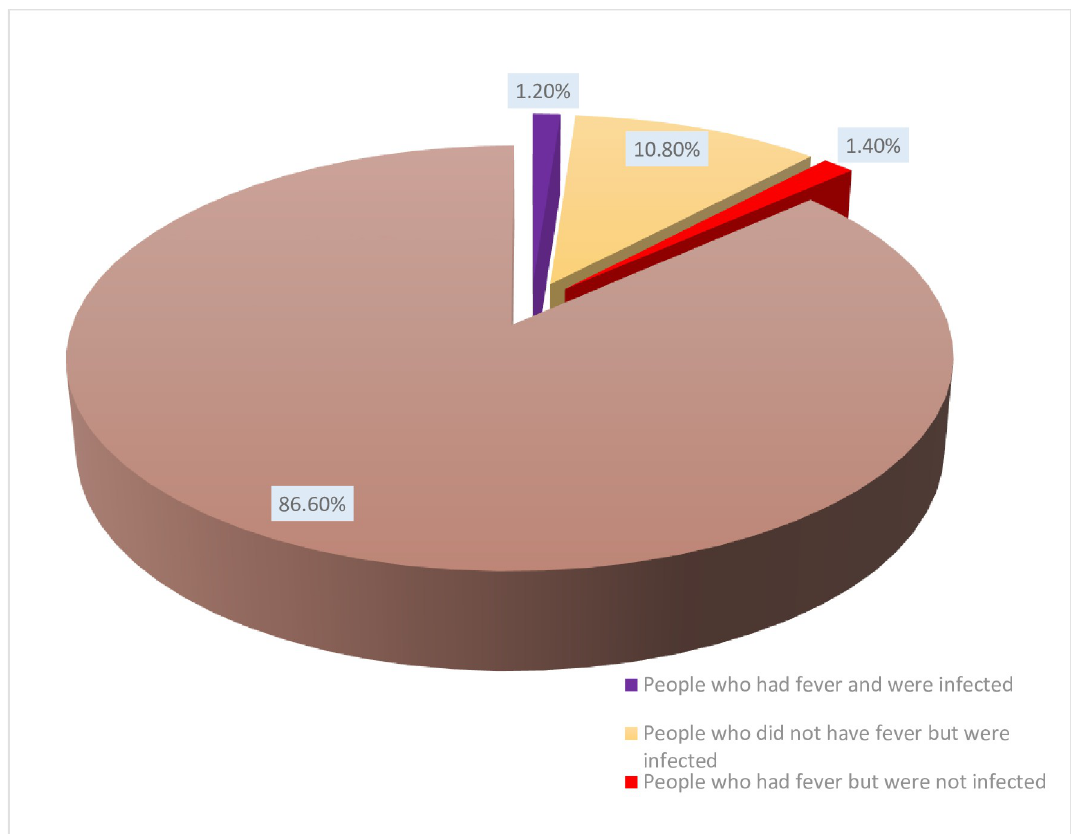
Fig 2. Prevalence of malaria in